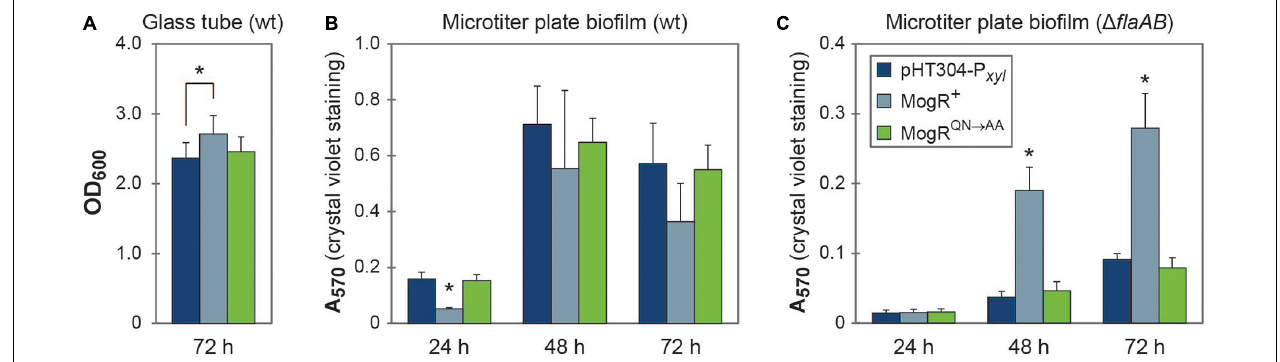
FIGURE 7 | MogR overexpression affects biofilm formation. (A) Biofilm formation in glass tubes after 72 h of growth. (B,C) Biofilm formation in a crystal violet microtiter plate assay after 24, 48, and 72 h of growth. The legend shown in (C) also applies to figures (A,B) . The means and standard error of the means for (A) five or (B,C) three independent experiments is shown. Statistically significant differences (within each time point; Tukey’s post hoc test, p < 0.05) are indicated with an asterisk (*); in (B,C) the asterisk (*) indicates that the MogR + strain demonstrates a statistically significant difference to both the empty vector control strain and the overexpression of a mutated form of MogR (MogR QN → AA ). In (A) , only the MogR + and empty vector control strains (pHT304-P xyl ) were significantly